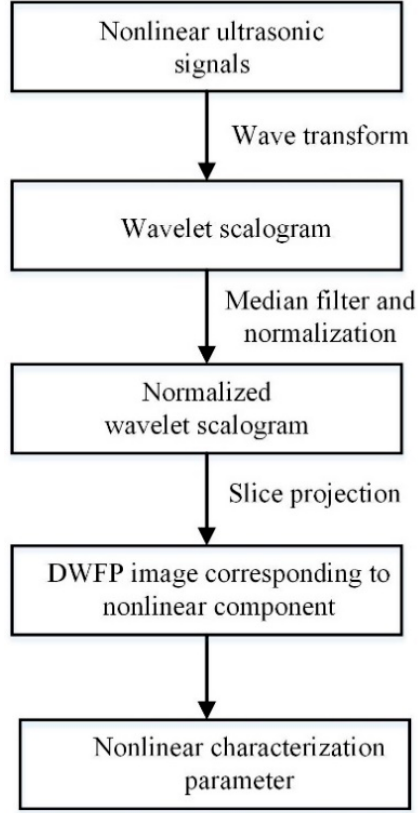
Figure 1. Flow diagram of extracting the nonlinear characteristic parameter using DWFP technology.